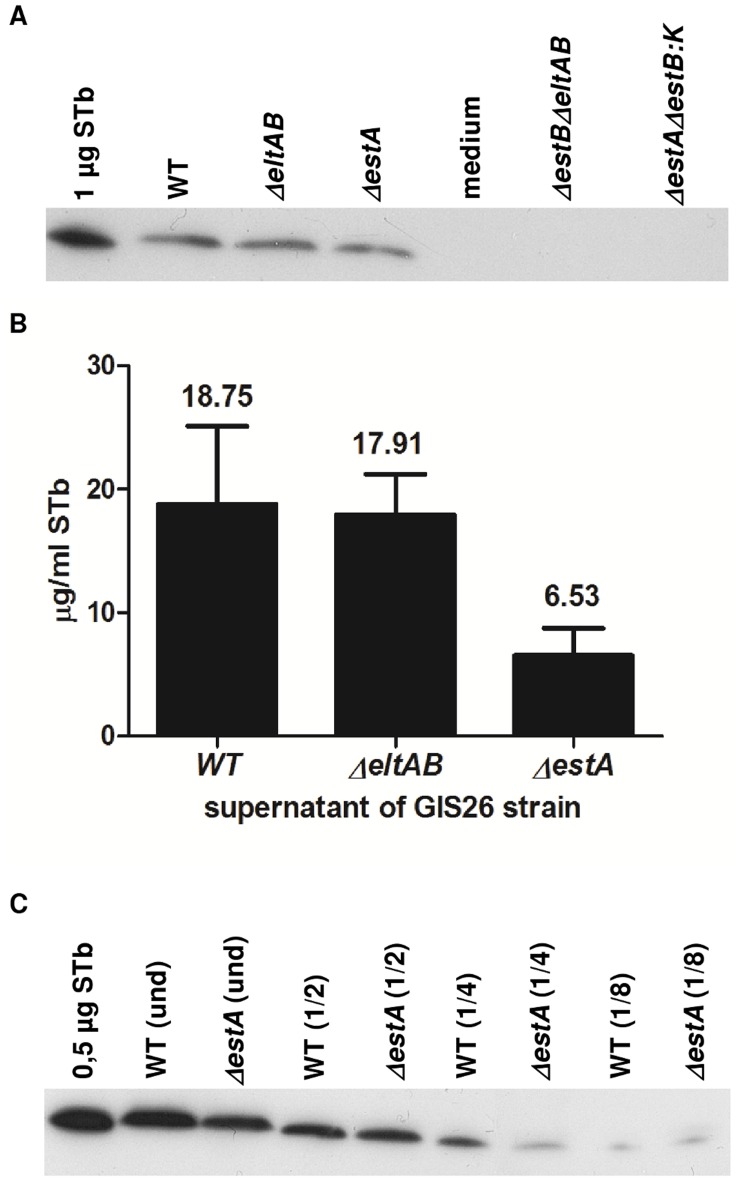
Detection of STb expression by different isogenic ETEC strains following in vitro culture.(A) STb detection with Western blotting. For every GIS26 mutant an equal amount of filtered supernatant was loaded (30 µl), data are representative for 3 independent experiments. (B) In the STb positive strains, STb was quantified by a direct ELISA. Mean values±SD are shown; results are representative for 3 independent experiments. (C) A difference in amount of STb produced between the wild type strain and the GIS26ΔestA mutant was also detected by Western blotting of different dilutions of the supernatant of both strains (20 µl per lane).